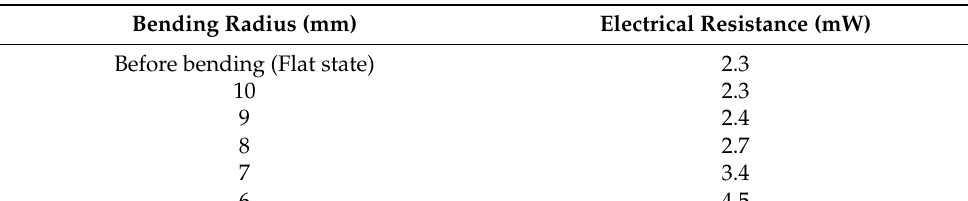
Table 2. Measurement of the electrical resistance for different bending radii.